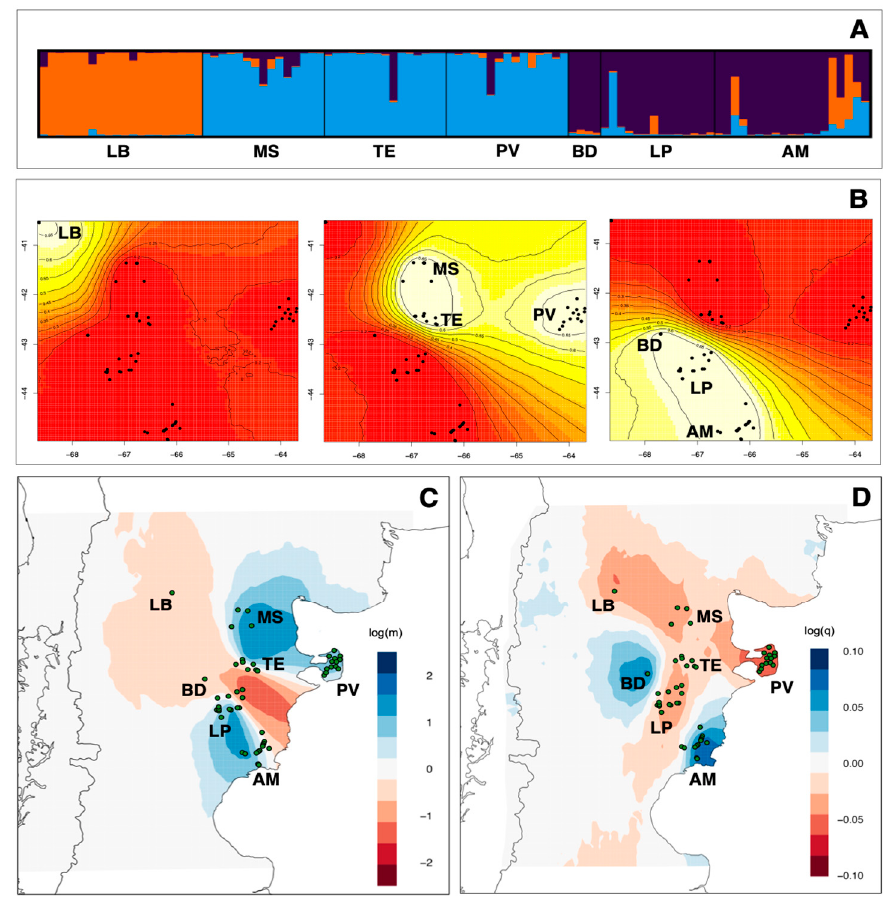
Figure 2. ( A ) Results of cluster analyses of guanacos depicted as a plot of the posterior probability of assignment of 102 guanacos (vertical lines) in three genetic clusters (K = 3) based on Bayesian analysis of microsatellite variation. The individuals are grouped by locality, and localities are indicated along the horizontal axis. The localities’ names are LB = Loma Blanca; MS = Meseta Somuncura; TE = Telsen; PV = Península Valdés; BD = Bajada del Diablo; LP = Las Plumas; AM = Ameghino. ( B ) Results of the posterior probability of Geneland analyses based on patterns of microsatellite variation, with K fixed at 3. Regions with the greatest probability of inclusion are indicated in white, whereas diminishing probabilities of inclusion become from white, yellow to red. Black dots represent sampling sites, and the dashed ovals show the locality groups. Estimates of effective migration ( C ) and diversity ( D ) surfaces inferred by EEMS for the north Patagonia population of Lama guanicoe . In ( C ), blue colors represent estimated effective migration greater than would be expected under isolation-by-distance, and darker red colors represent increasingly higher migration. In ( D ), blue colors represent regions of elevated genetic diversity, and increasingly dark red colors represent regions of decreased genetic diversity. Circles represent the four sampling localities in this study.